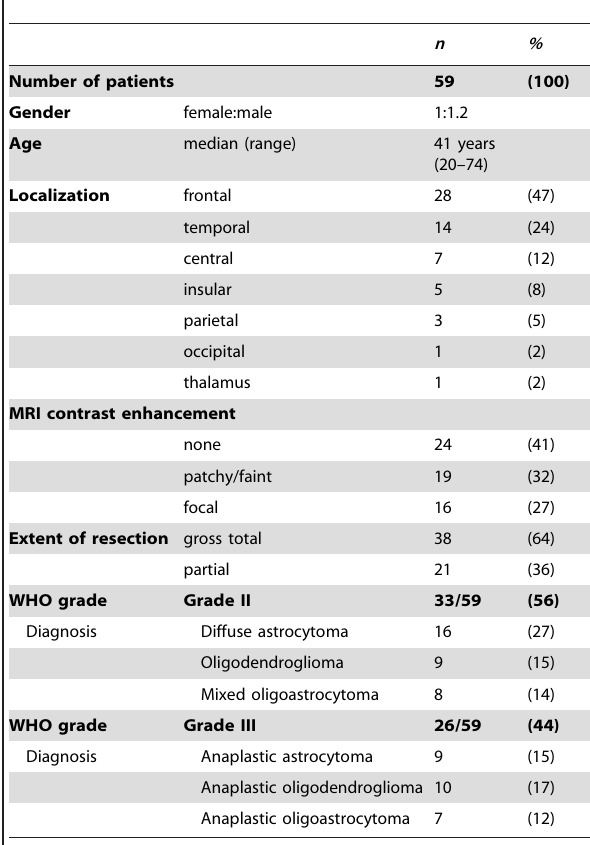
Table 1. Patient